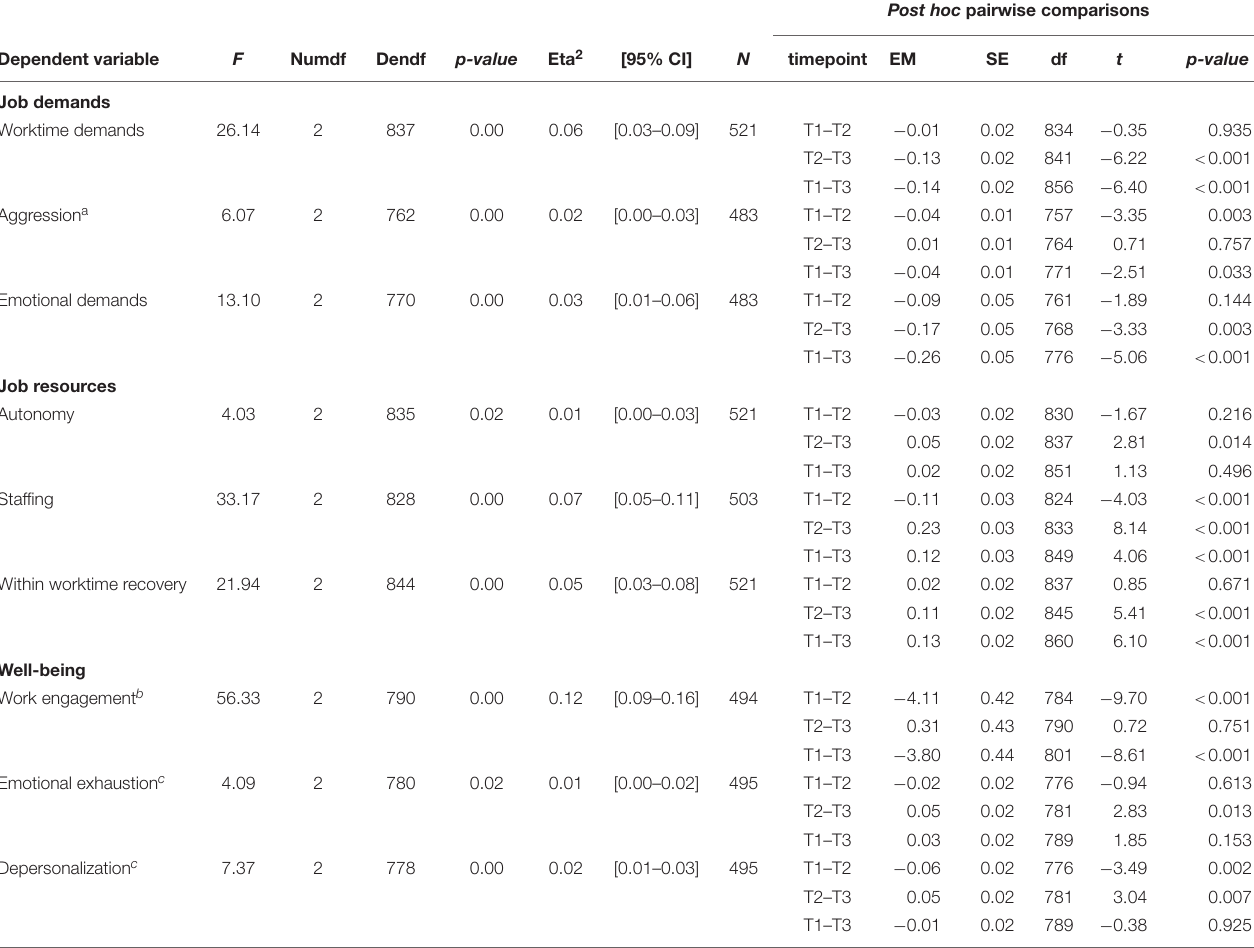
TABLE 1 | Changes over time in job demands, job resources and well-being during the intervention